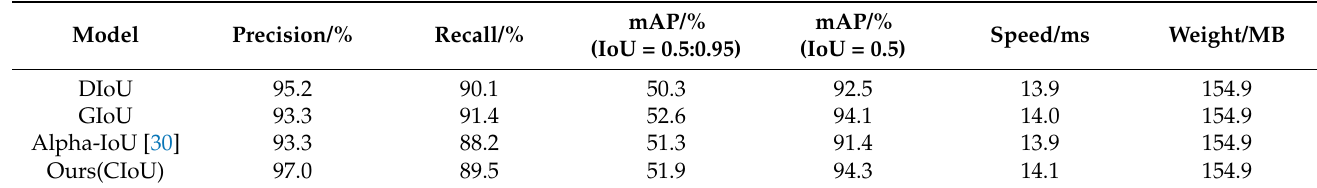
Table 7. Ablation experiment results of CEBD-YOLO by using different loss functions.